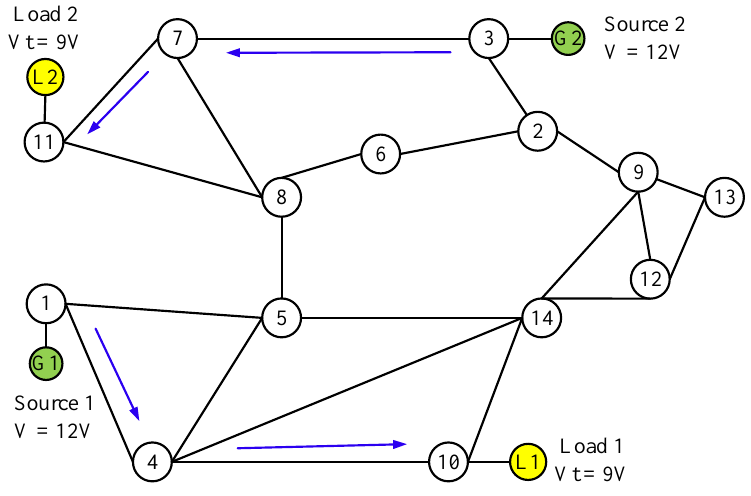
Figure 4. IEEE 14 test bus as a digital microgrid (DMG) network with EPSs as network